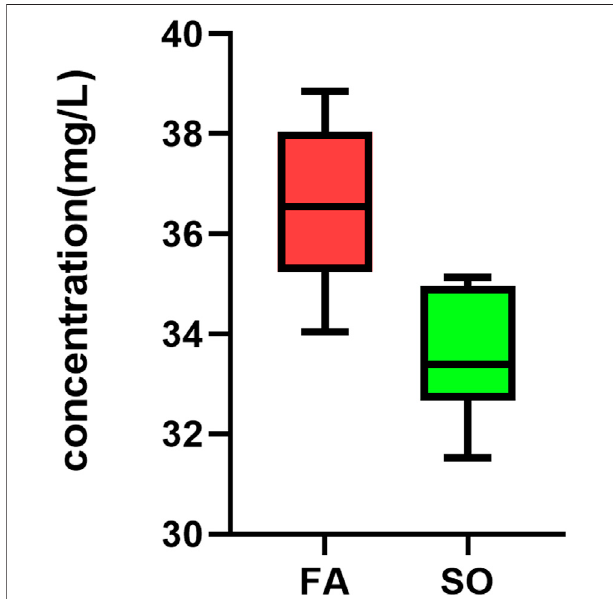
FIGURE 6 | Box plots showing TF levels. To validate the fi nding, TF was measured with ELISA in Ten SO group and 5 FA group that were matched according to age and sex. TF was signi fi cantly downregulated in SO eyes relative to FA eyes ( p -value (cid:1) 0.002, independent-samples t -test; n (cid:1)